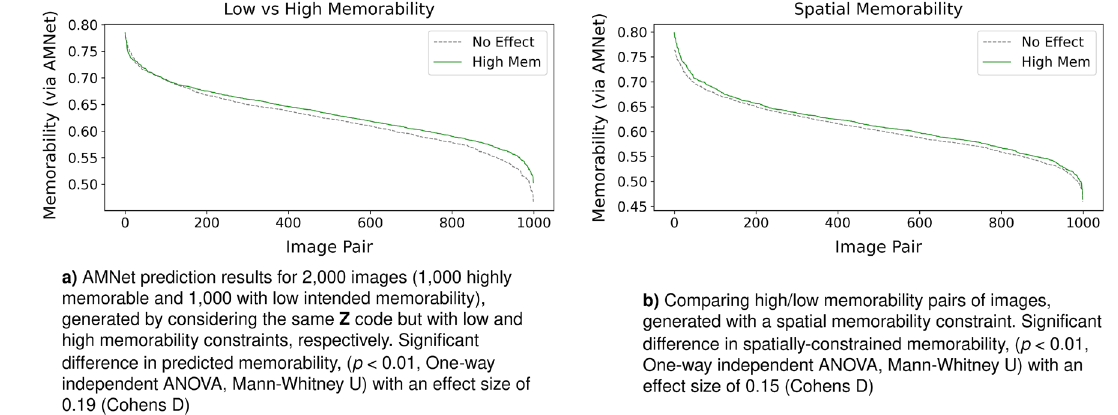
Figure 4. Differences in predicted memorability for low and highly memorable images generated with